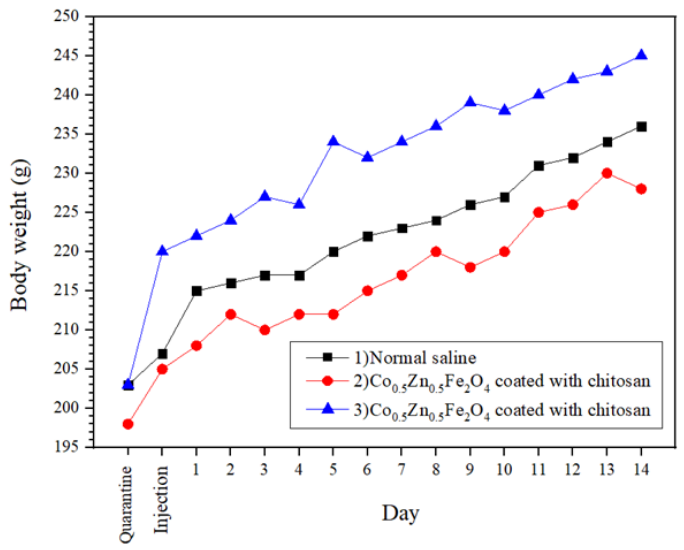
Figure 6. Wistar rat body weight changes in acute systemic toxicity with chitosan-coated Co 0.5 Zn 0.5 Fe 2 O 4